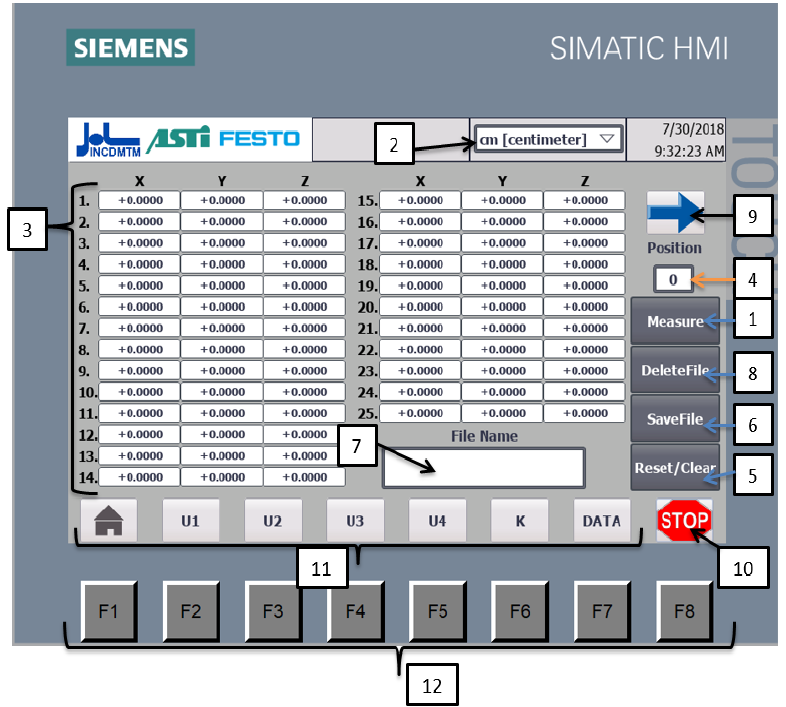
Figure 15. Coordinate measurement with the MMI4D system.